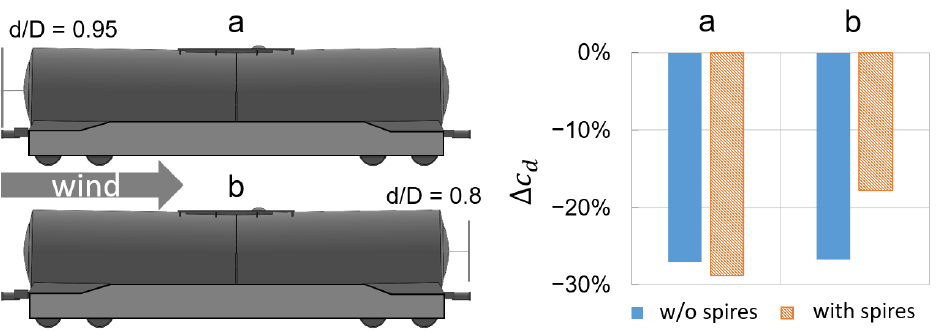
Figure 11. Inter-wagon disc and side-skirts combined ( left ); drag reduction through combination ( right ). a inter-wagon disc at upstream face; b inter-wagon disc at downstream